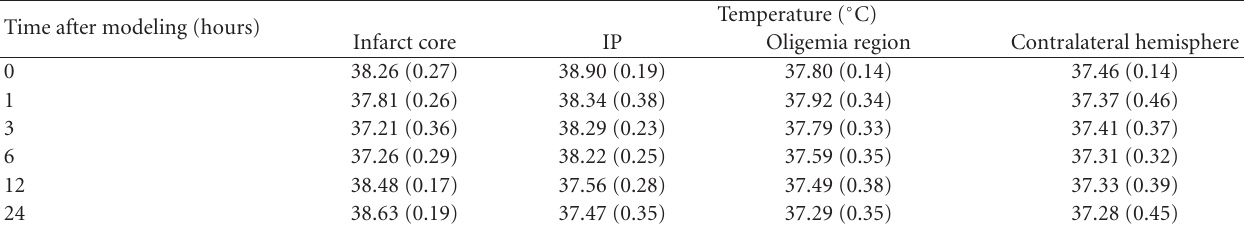
Figure 1: Definition of di ff erent ischemic regions. DWI (a) and MTT (c) at the artery occlusion stage and T 2 WI (b) at 24 h are used to define the infarct core, IP, and oligemic region. On the localized DWI of MRS (d), overlapped imaging shows the infarcted core (white), IP (yellow), and oligemia (red). Table 2: The brain temperature of di ff erent ischemic tissues and contralateral hemisphere at artery occlusion stage (0h) and di ff erent time points of reperfusion stage in monkey MCAO